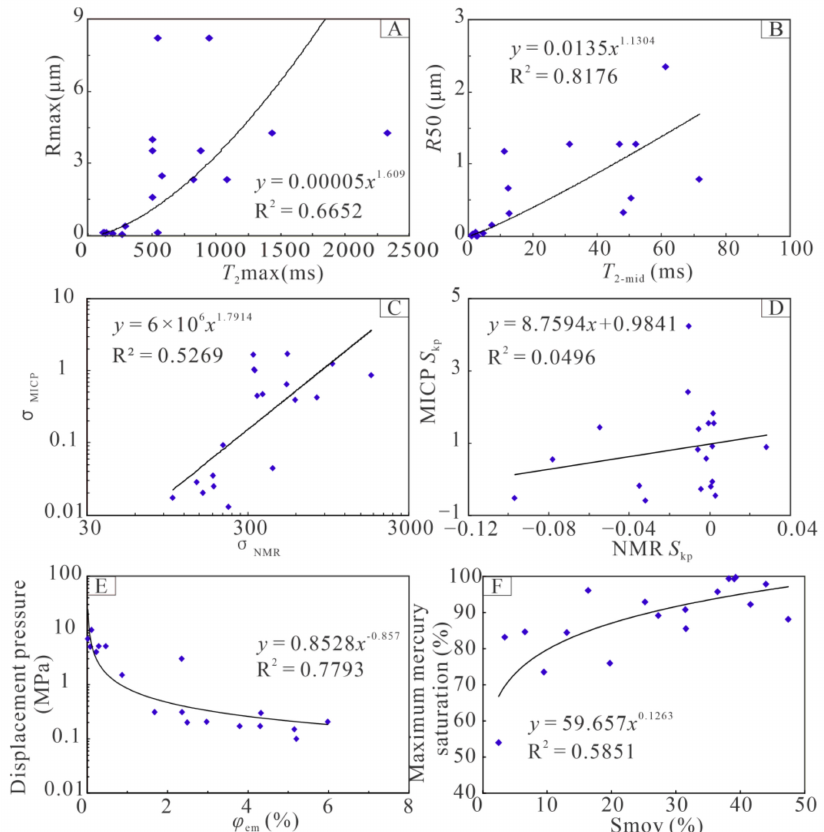
Figure 15. Comparative analysis of NMR T 2 spectral parameters and MICP capillary parameters. ( A ) T 2max versus R max ; ( B ) T 2mid versus R 50 ; ( C ) σ NMR versus σ MICP ; ( D ) NMR S kp versus MICP S kp ; ( E ) ϕ em versus displacement pressure; ( F ) S mov in NMR experiment and maximum mercury saturation from MICP